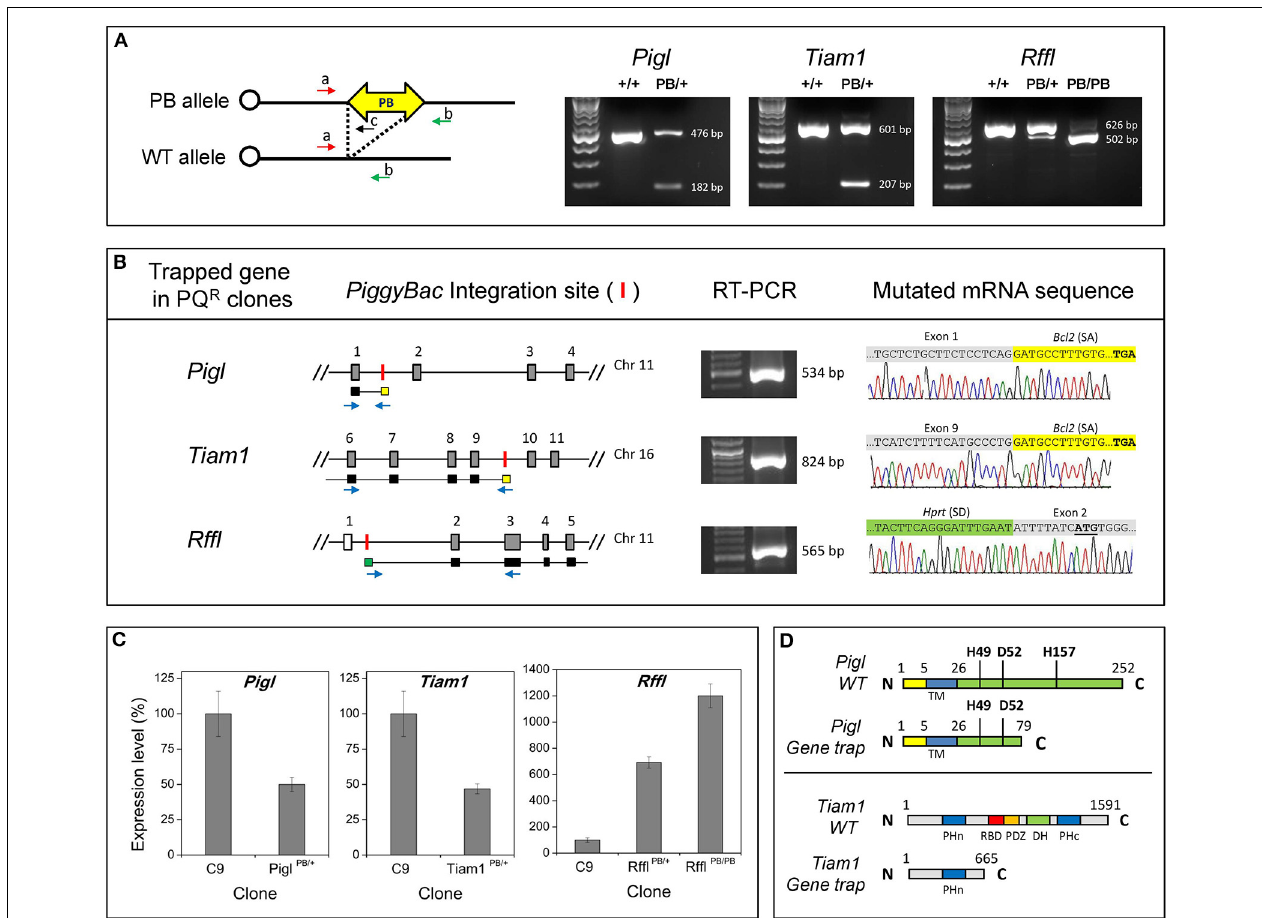
FIGURE 2 | Analysis of mutational events. (A) Genotyping of the PB-mediated gene-trap mutants. A 3-primer methodology was used to analyze PB mutant clones. Flanking primers a and b will amplify an endogenous genomic fragment. However, in the PB allele, the distance between a and b is so large that no PCR product will be formed, under a short extension; instead primers a and c (annealing to the PB) will produce a product. Allele specific PCR product was visualized on an agarose gel. (B) Genomic location of PB insertion. PQ R ES clones with the PB insertion site shown graphically (not in scale). The red vertical bar represents the site of PB insertion. Black horizontal bars under the exons represent the DNA sequence being transcribed into mRNA; the yellow box and green box represent the PB-UPA splice acceptor (SA) sequence and the splice donor (SD), respectively. The thin lines between these bars illustrate the joining of these DNA sequences. Mutant mRNA was detected by reverse transcription (RT)